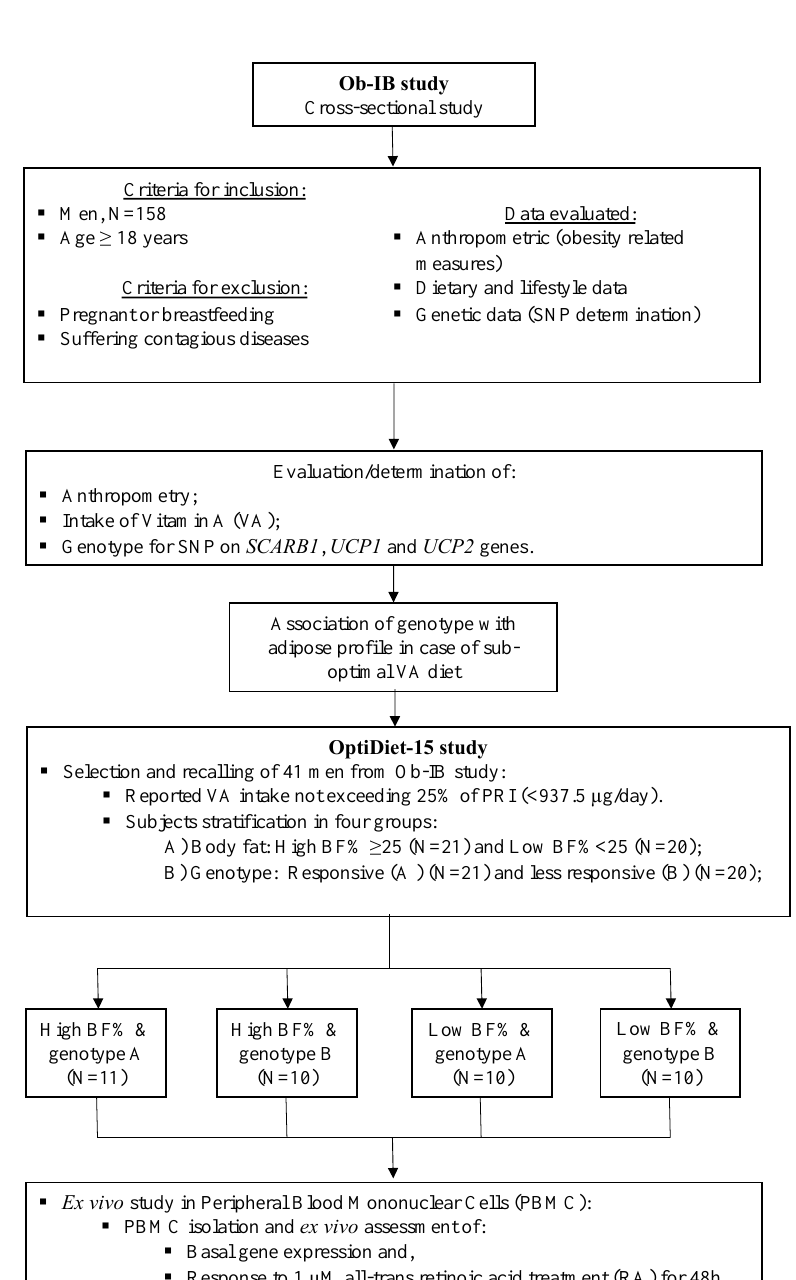
Figure 1. Flowchart diagram of the study. Flowchart diagram of the main steps of the study, including data sets recorded, criteria established for subject selection, number of subjects taken into account, and main procedures followed at each stage. PRI-Population Reference Intake, SNP-single nucleotide